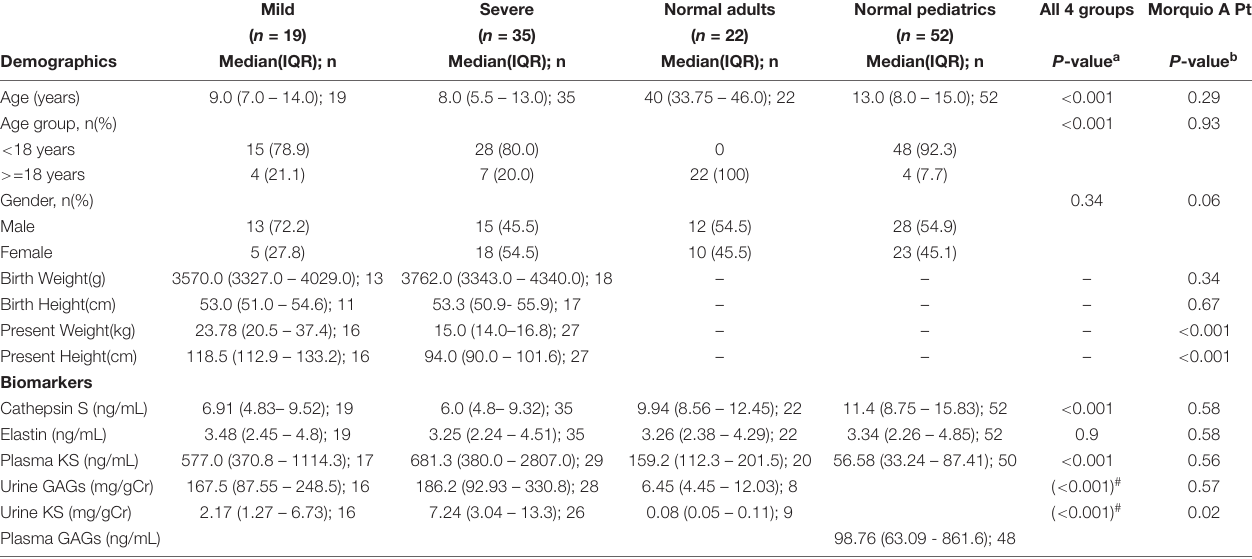
TABLE 1 | Demographic and biomarker comparisons of Morquio A patients by severity and normal controls. Mild Severe Normal adults Normal pediatrics All 4 groups Morquio A